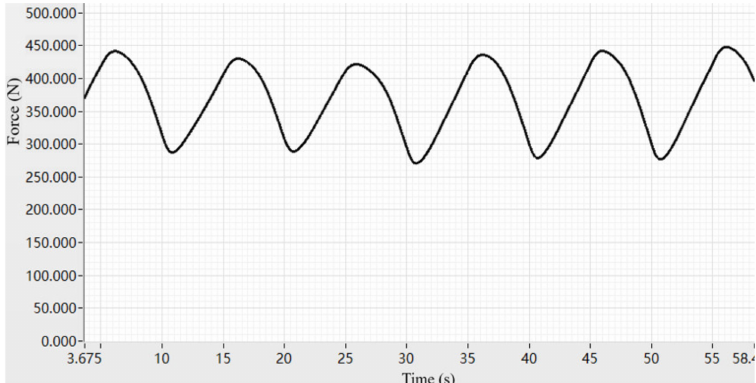
Figure 20. Lateral force waveform under sinusoidal command.